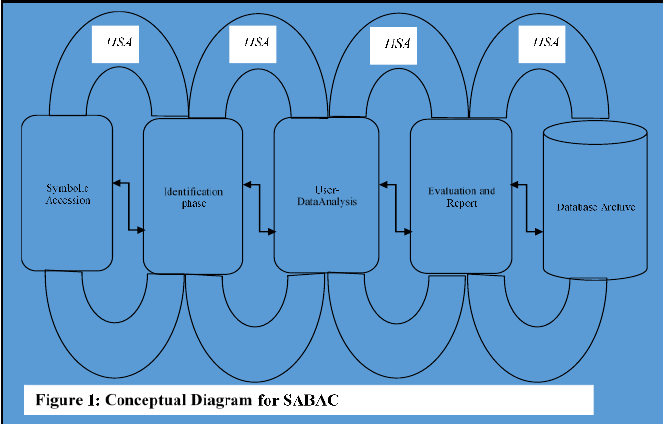
Figure 1: Conceptual Model of